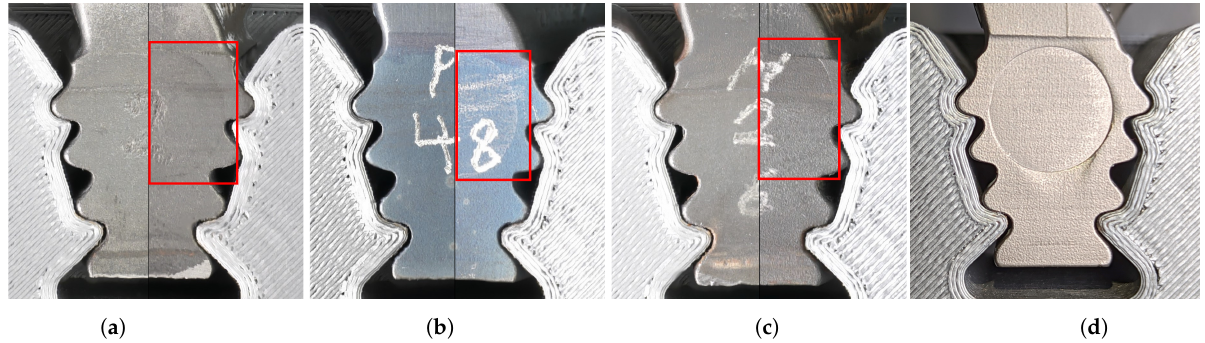
Figure 14. Visual changes due to load exertion on the blade root. ( a ) Disassembly force 50kN. ( b ) Disassembly force 60kN. ( c ) Disassembly force 70kN. ( d ) Disassembly force